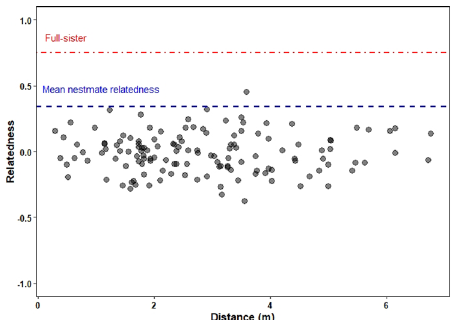
Fig. 3 Association between genetic relatedness and spatial distance among nests in a population of the ant Cardiocondyla elegans . Association between genetic relatedness and spatial distance among 16 colonies ( n = 7 workers per colony) of the ant Cardiocondyla elegans in collecting site RFRK in 2018. The red dashed and dotted line represent the value of relatedness expected for full sisters (0.75), the blue dashed line represents the empirically determined mean relatedness among nestmate (2018: 0.34 ± 0.05, see